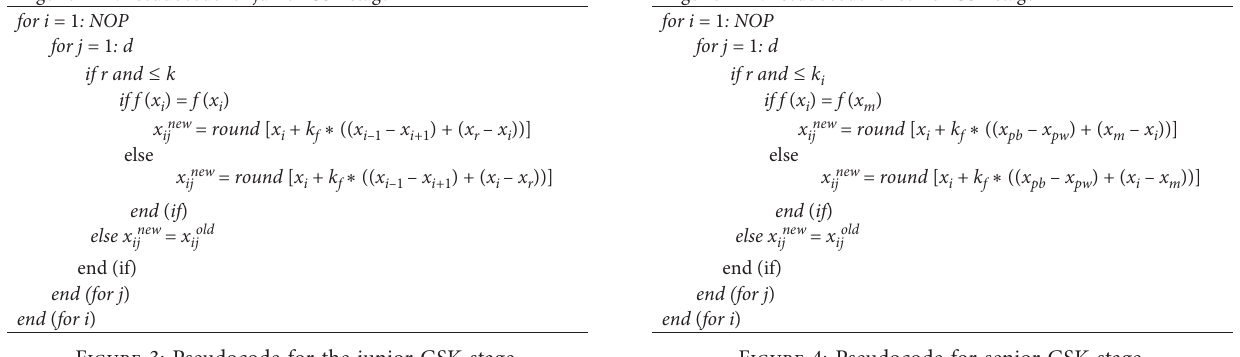
Algorithm 2: Pseudocode for senior GSK stage for i = 1 : NOP